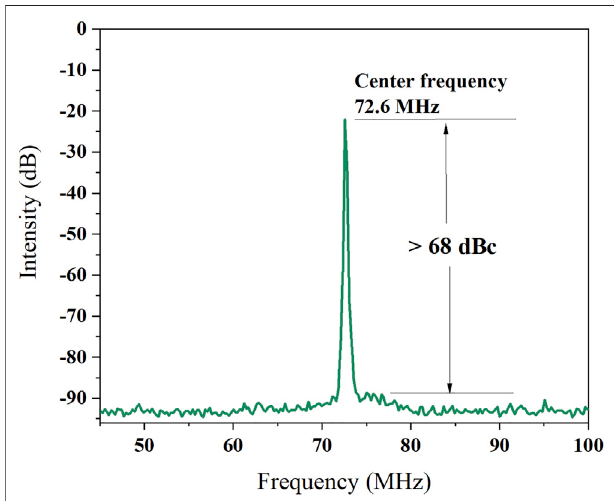
FIGURE 5 | Radio frequency spectrum of the mode-locked pulses at 2,347 nm center wavelength.